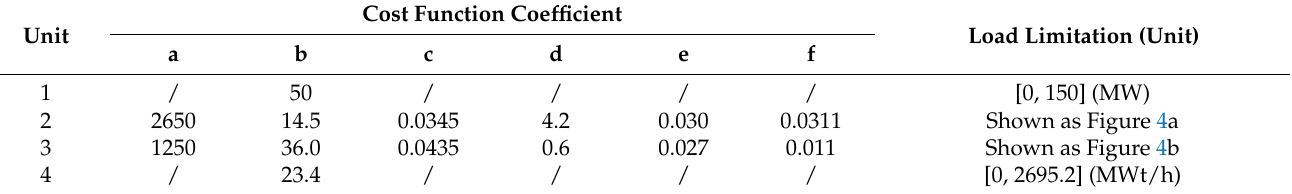
Table 1. Characteristic parameters of test system I.